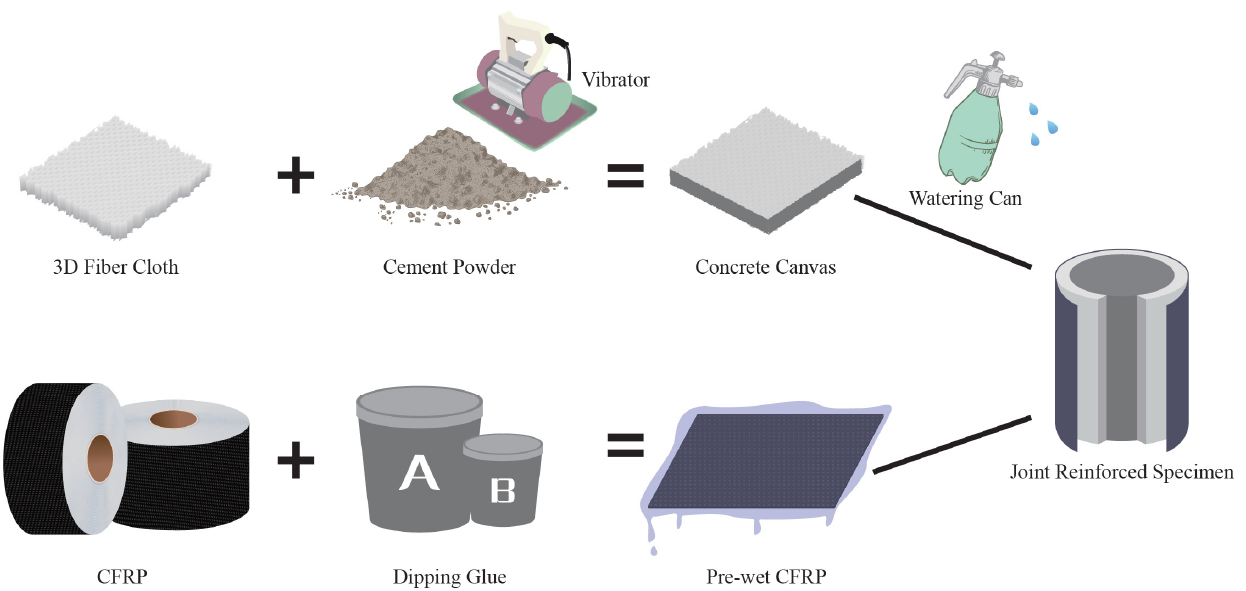
Figure 3. Schematic diagram of the reinforcement process of the jointly reinforced specimen.